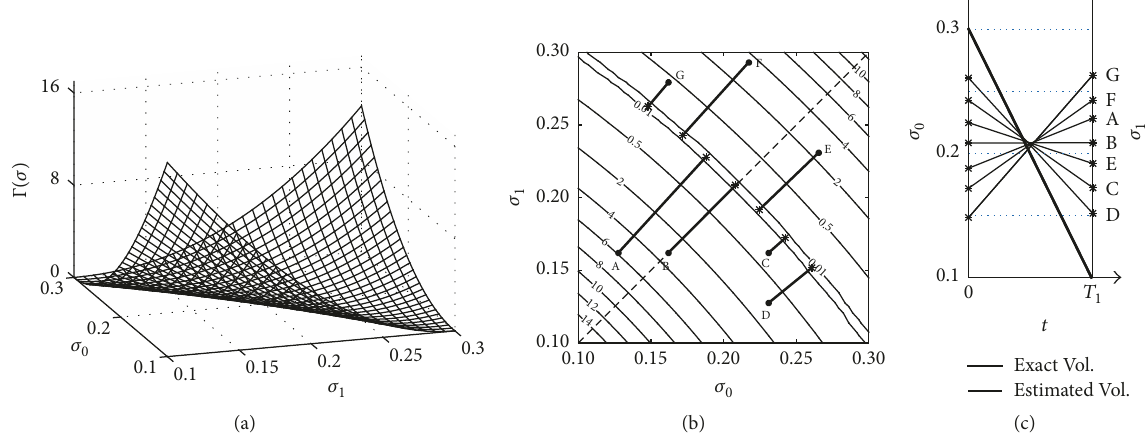
,𝜎 ≤ 0.3 . (b) Contour lines of the cost 0 1